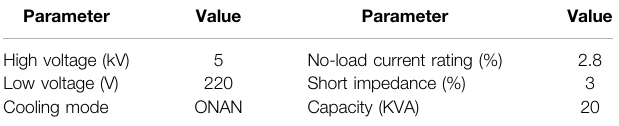
TABLE 1 | Transformer technical parameters.